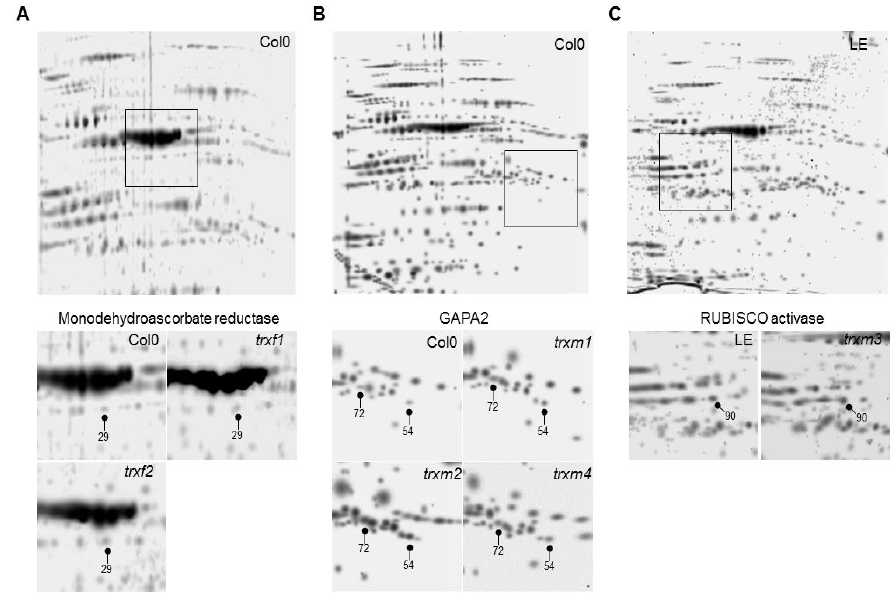
Figure 2. DE images from rosette of trxf1, f2, m1, m2, m3 and m4 mutants. 2-D images of total proteins from rosettes of trx f1 and f2 ( A ) , m1, m2 and m4 ( B ), and m3 ( C ) mutants in comparison with Col0